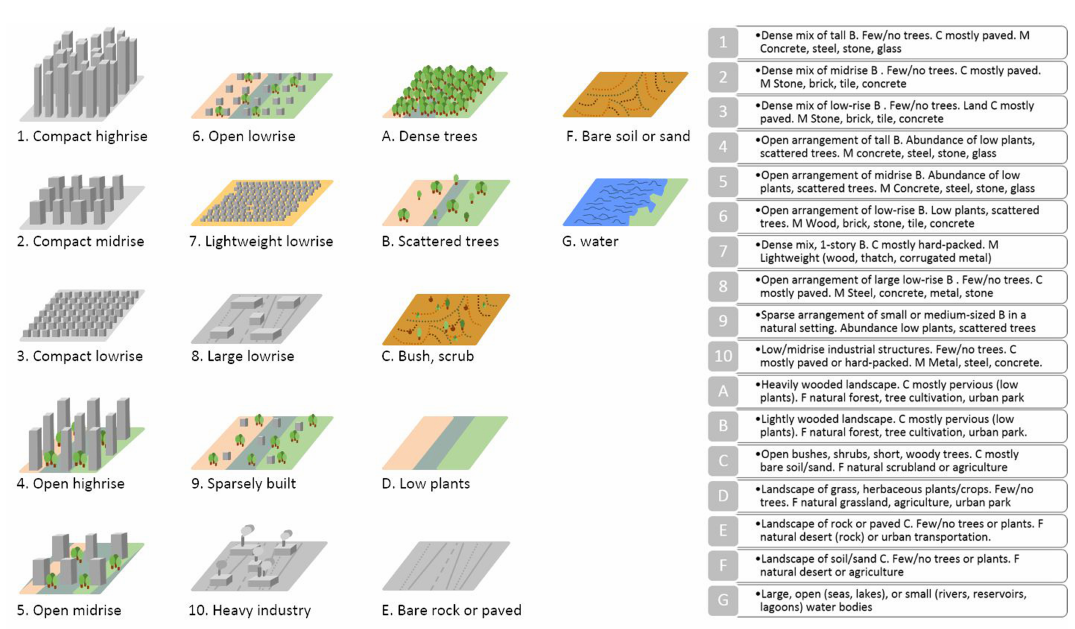
Figure 1. Urban ( 1 – 10 ) and natural ( A – G ) LCZ types and their characteristics (adapted from Table 2 in Stewart and Oke [2], text shortened, icons reworked) B: Buildings; C: cover; M: materials; F: